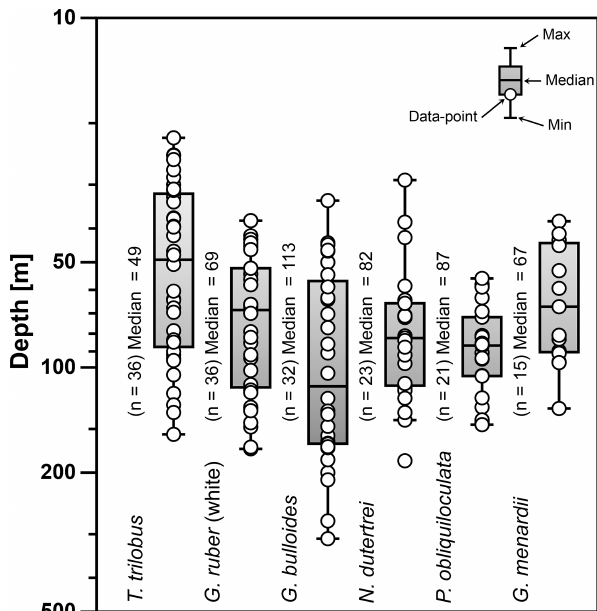
Figure 6. Average living depth (ALD) of the species T. trilobus , G. ruber (white), G. bulloides , N. dutertrei , P. obliquiloculata , and G. menardii . The calculation includes only stations with more than five specimens per species ( n ). Schematic of the box plots showing the median value (horizontal line); the whisker marks the minimum (min) and maximum (max) values. Symbols (white circles) depict the ALD values. Note log scale for y